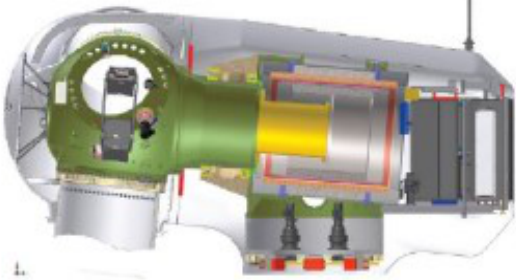
Fig.7 10MW Seatitan offered by AMSC. Reproduced from[1]